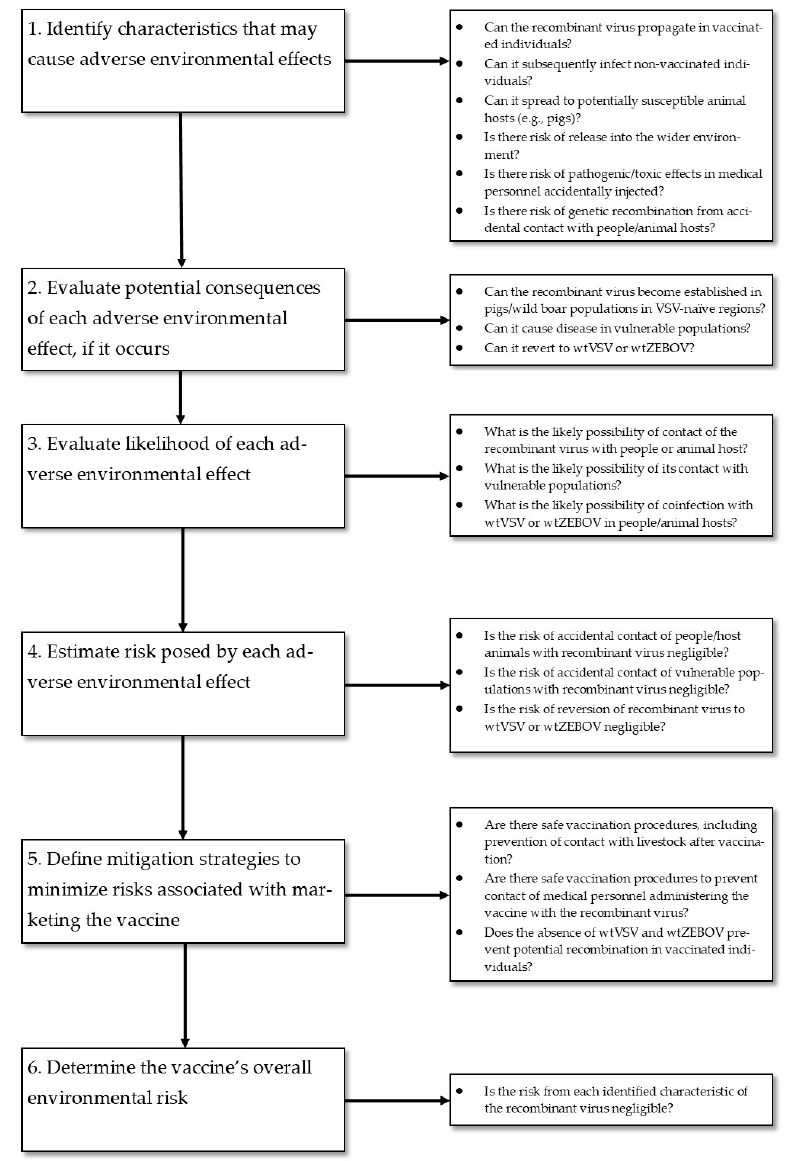
Figure 3. Steps required to conduct an ERA for a GMO medicinal product under EMA regulations ( left -hand column), illustrated by specific assessment examples from the ERA for rVSV Δ G-ZEBOV- GP ( right -hand column).